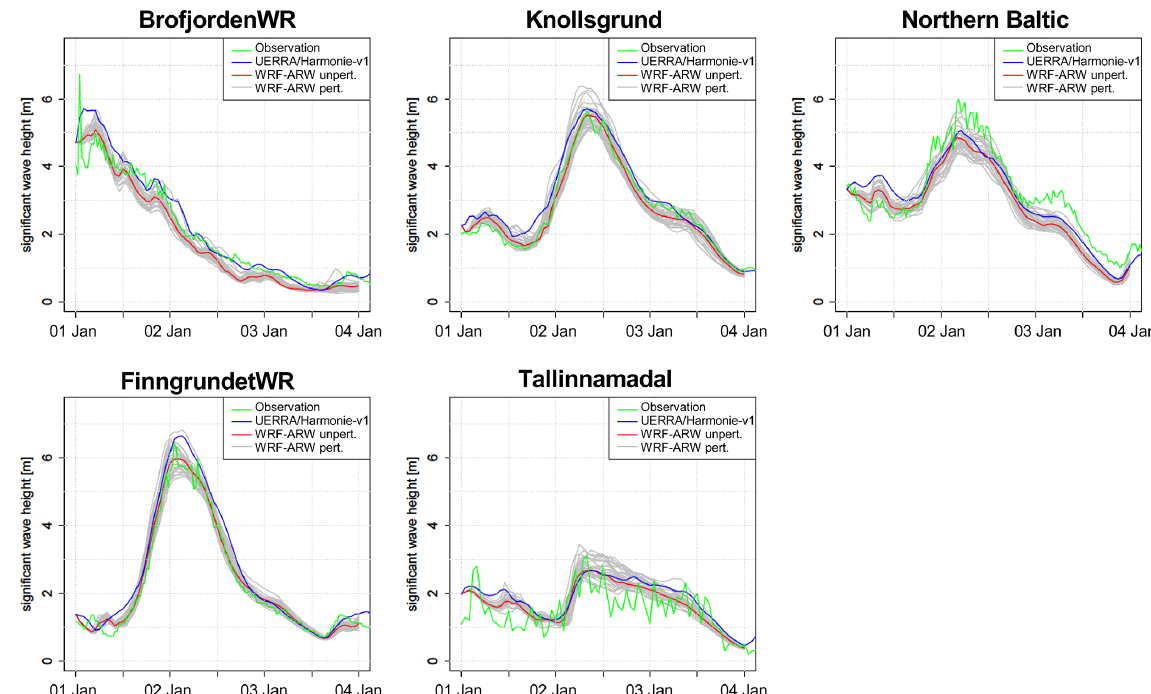
Figure 3. Significant wave height at five stations from the 1 nautical mile WAVEWATCH III ® model run. Wind data are from UERRA/HARMONIE-v1, WRF-ARW is unperturbed, and the 30 WRF-ARW members are generated with stochastic perturbations.